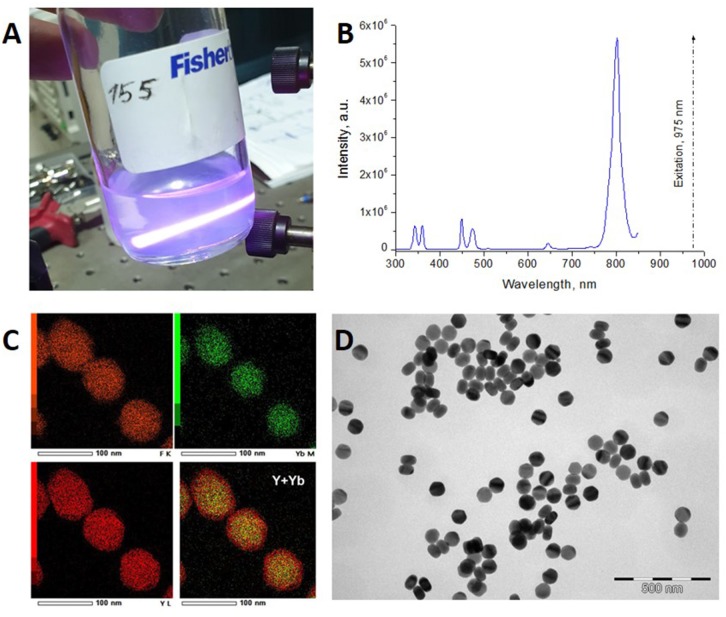
(A) UCNPs colloid illuminated with a 975-nm laser beam. Blue traces of photoluminescence illustrate conversion of NIR radiation in NPs. The image was taken via the interference filter Semrock (842-nm blocking edge BrightLine® short-pass filter Semrock, New York, NY, USA) cutting off 15 W/cm2 excitation at 975 nm. (B) Photoluminescence spectrum of UCNPs under excitation at 975 nm. (C) Elemental EDX mapping of NPs, overlay Y (red), and Yb (green) indicates core/shell structure of UCNPs. (D) Transmission electron microscopy (TEM) images of as-synthesized core/shell NaYF4:Yb3+, Tm3+/NaYF4 UCNPs with hexagonal prism shape (75-nm base and 50-nm height).